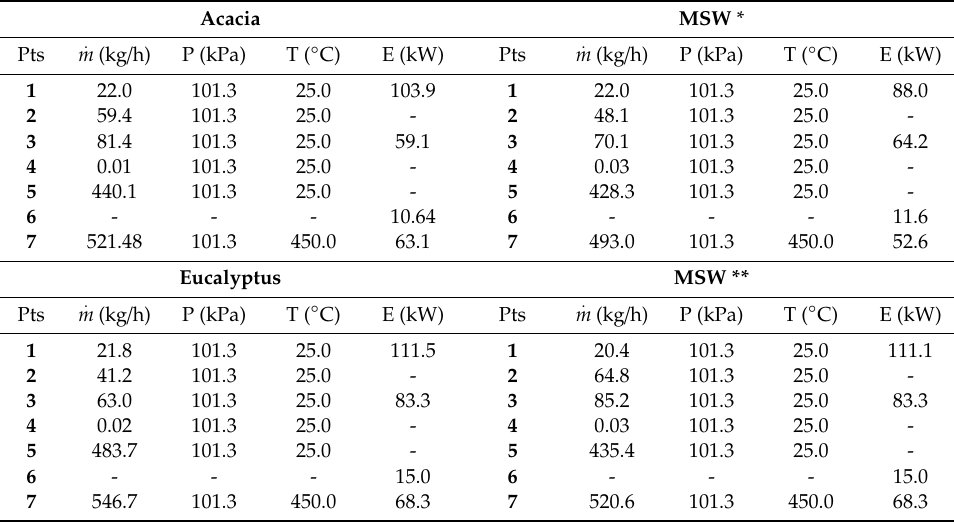
Table 8. Main results of the technical